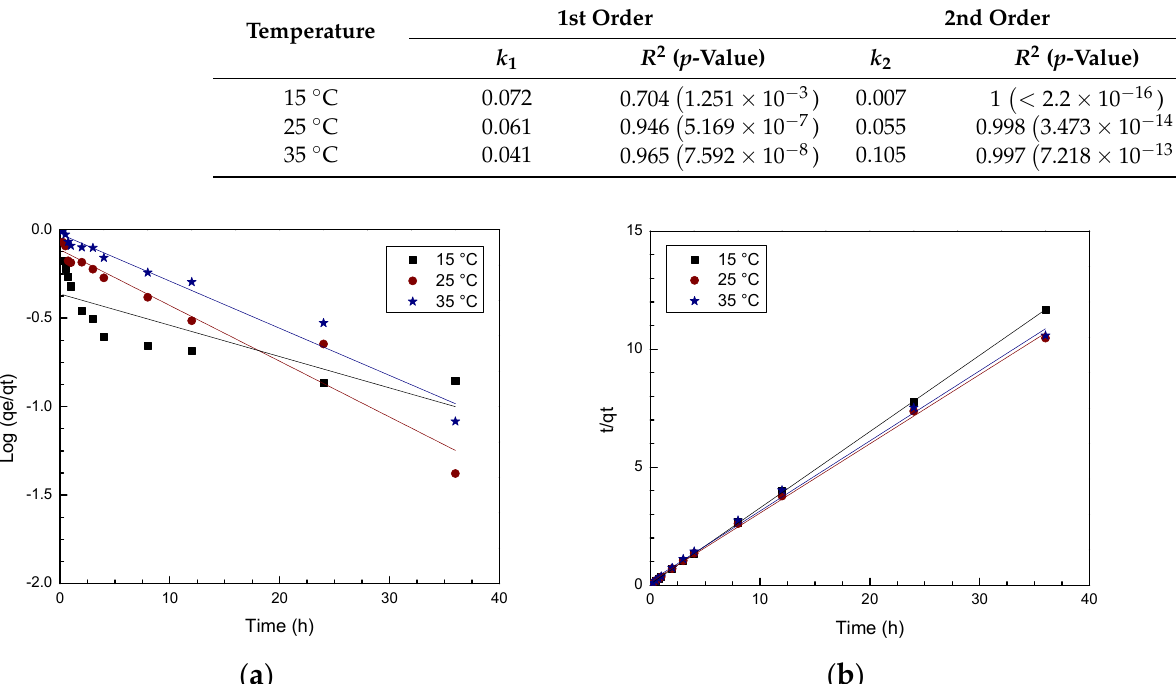
Figure 10. Adsorption kinetics for adsorption of RB5 on UBC ( a ) pseudo-first-order and ( b ) pseudo-second-order. Table 2. Pseudo-first- and pseudo-second-order kinetic parameters.